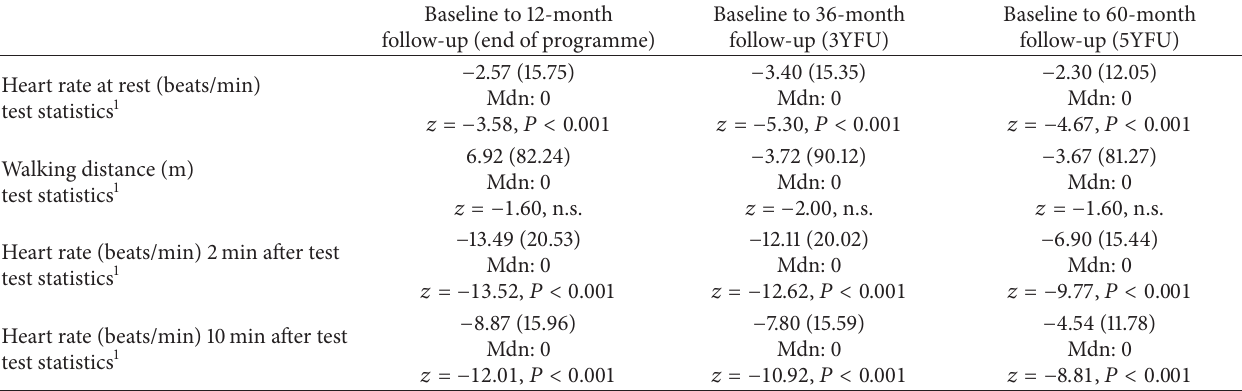
Table 6: Average changes in the walking test results after the end of the program and 3 and 5 years after start of the program (mean (SD)).